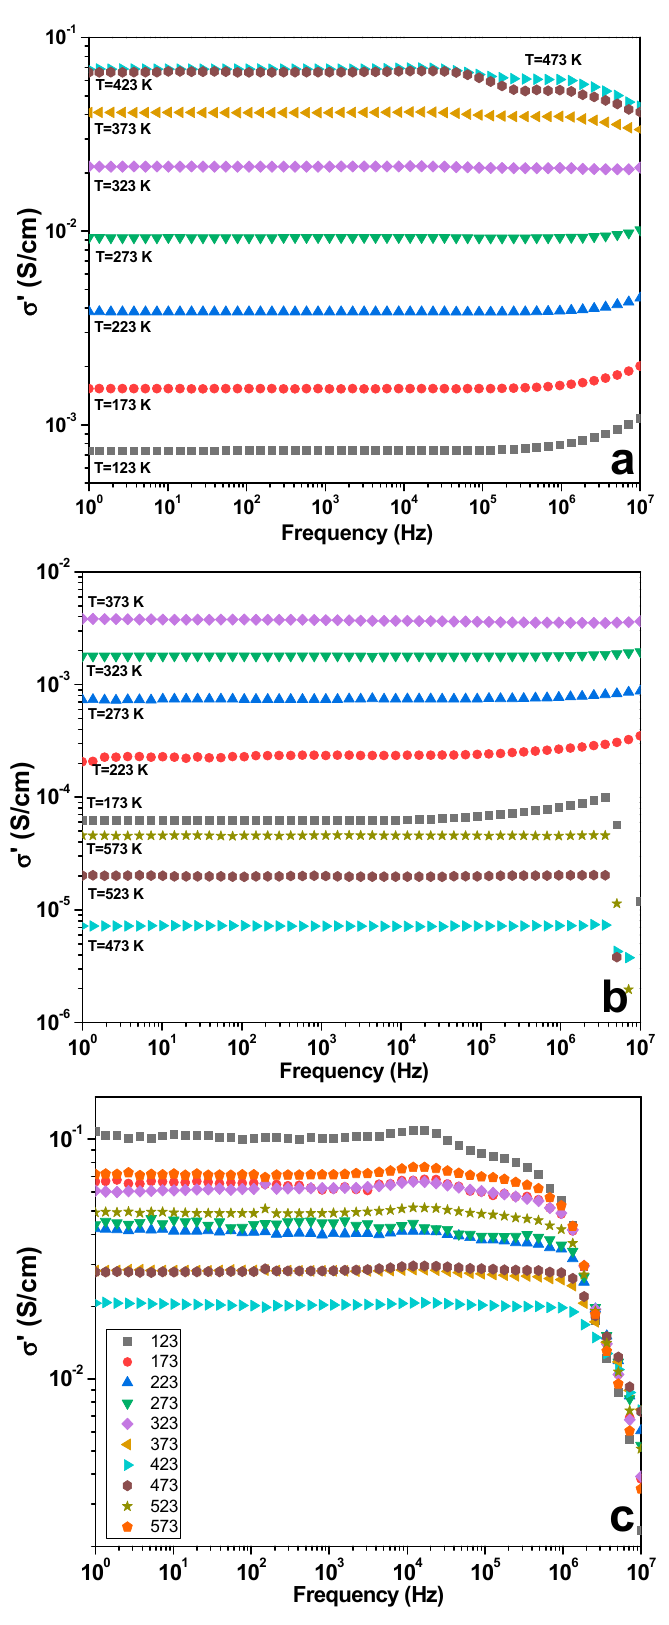
Figure 4. Spectra of the real part of conductivity at different temperatures for the La-CMFCNO ( a ), Nd-CMFCNO ( b ) and LN-CMFCNO ( c ) ceramic samples.